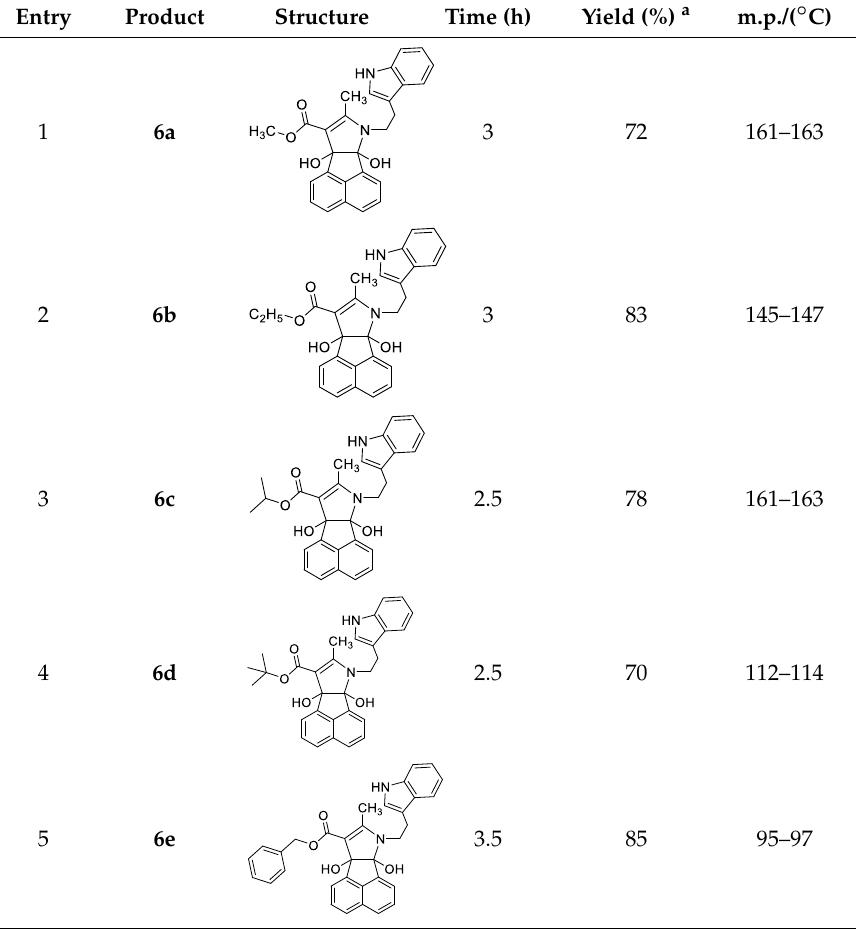
Table 3. The synthesis of compound 6